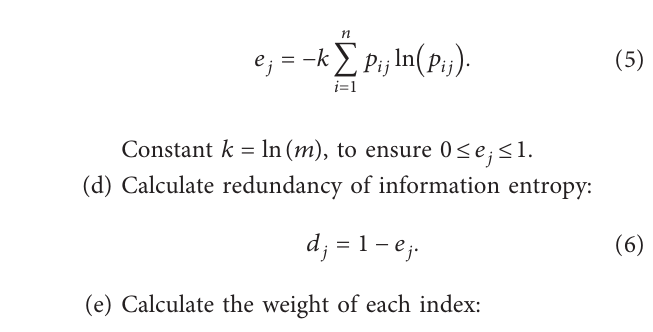
Figure 6: The minimum safe distance equivalent varies with each factor. (a) The average value of MSDE varies with traffic volume. (b) The value of MSDE varies with the proportion of large vehicles. (c) The average value of MSDE varies with the length of the transition